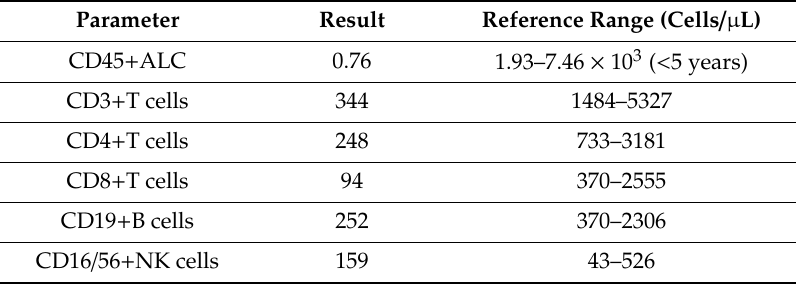
Table 3. Case 1, lymphocyte